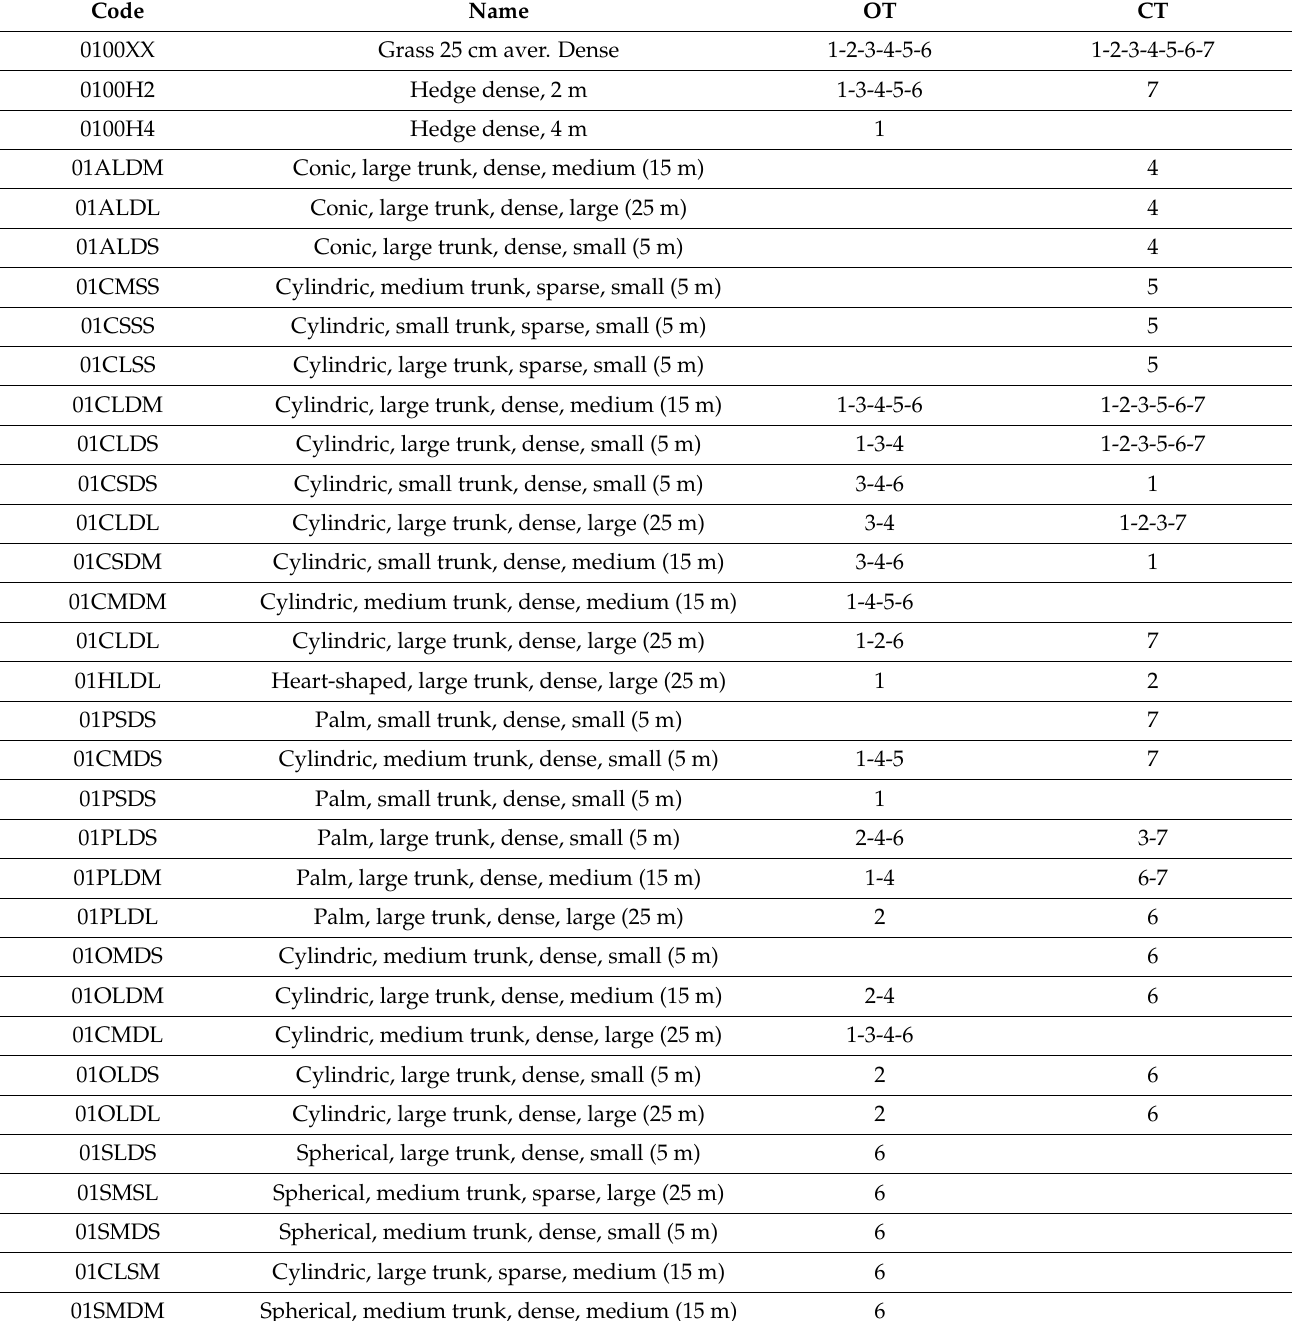
Table 6. The vegetation